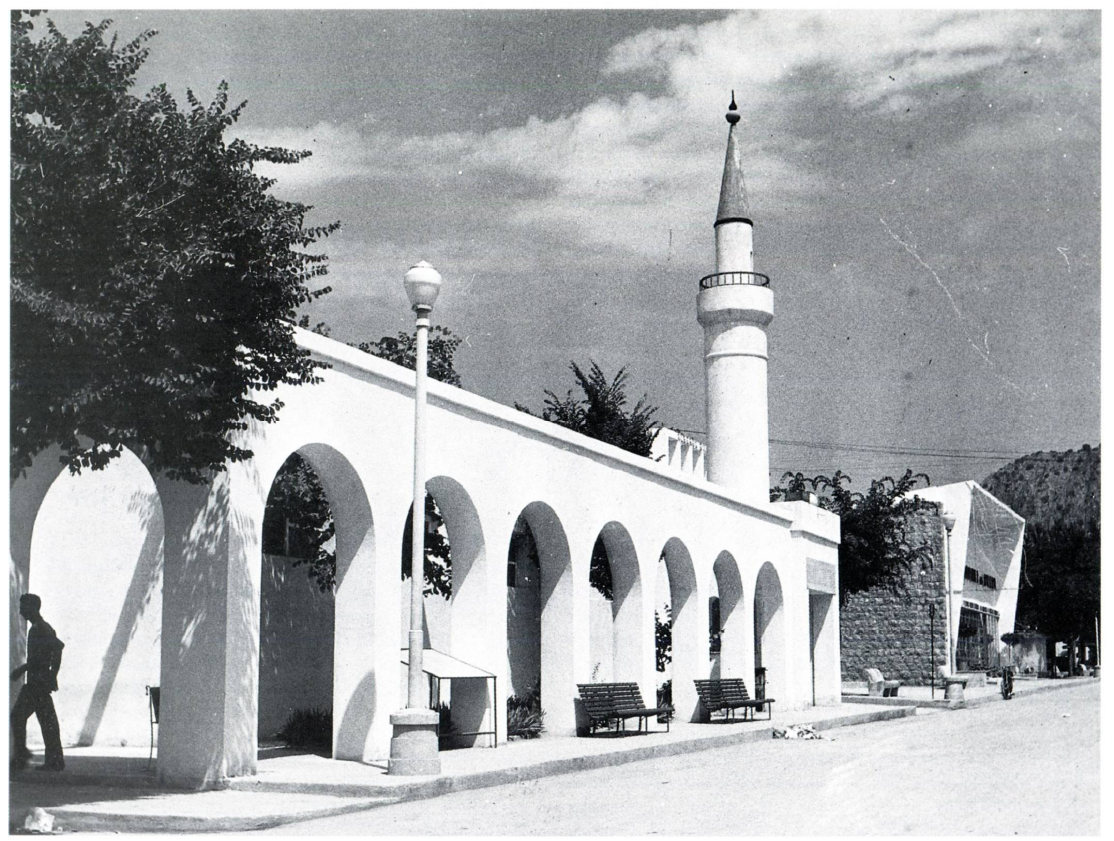
Figure 4. Libyan Pavilion,